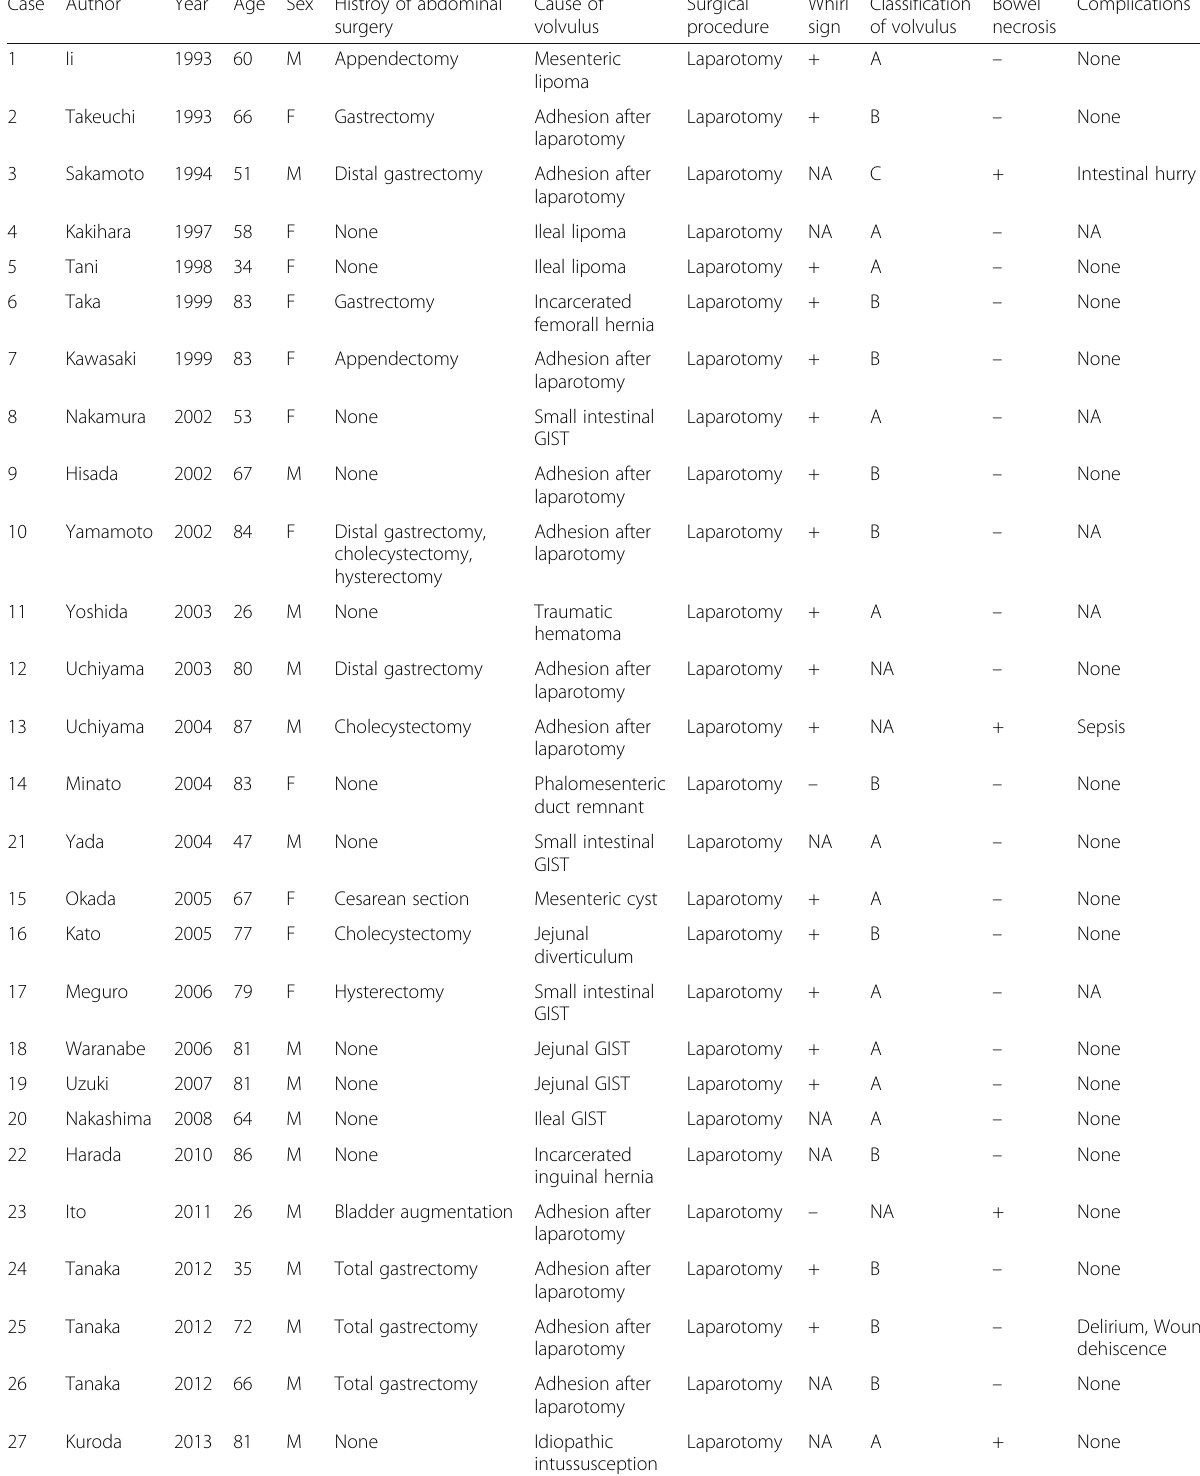
Table 1 Review of secondary small bowel volvulus cases reported in Japan Case